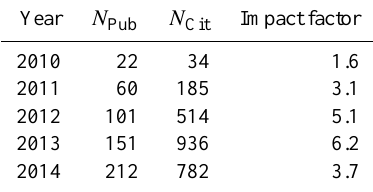
Table 1. Evolution of impact factor through